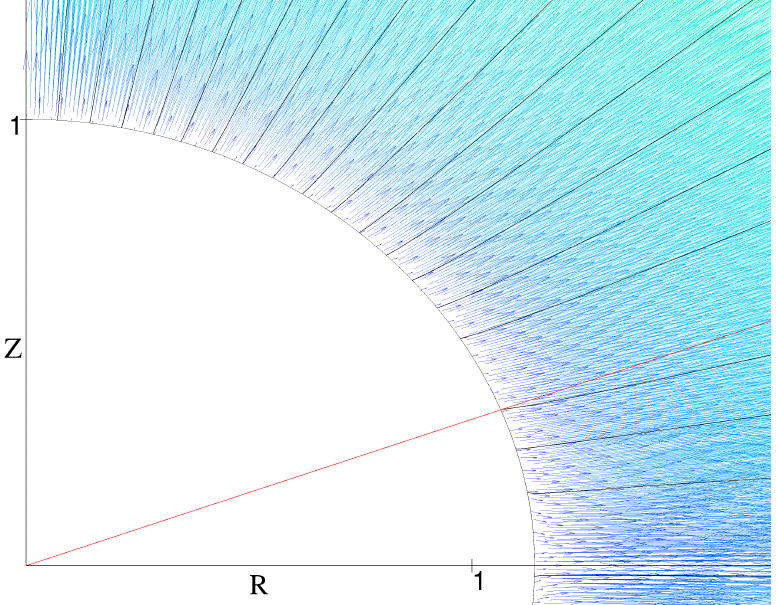
Figure 3. Flow lines and velocity vectors close to the surface of the star. The radial red line demon- strates that the flow lines are not radial from the very beginning. All the geometrical values are expressed in units of radius of the star at the pole R pole . T ef f corresponds to the sound velocity v 2 s = 4 × 10 − 3 . ˙ m 0 = 2.4 × 10 − 2